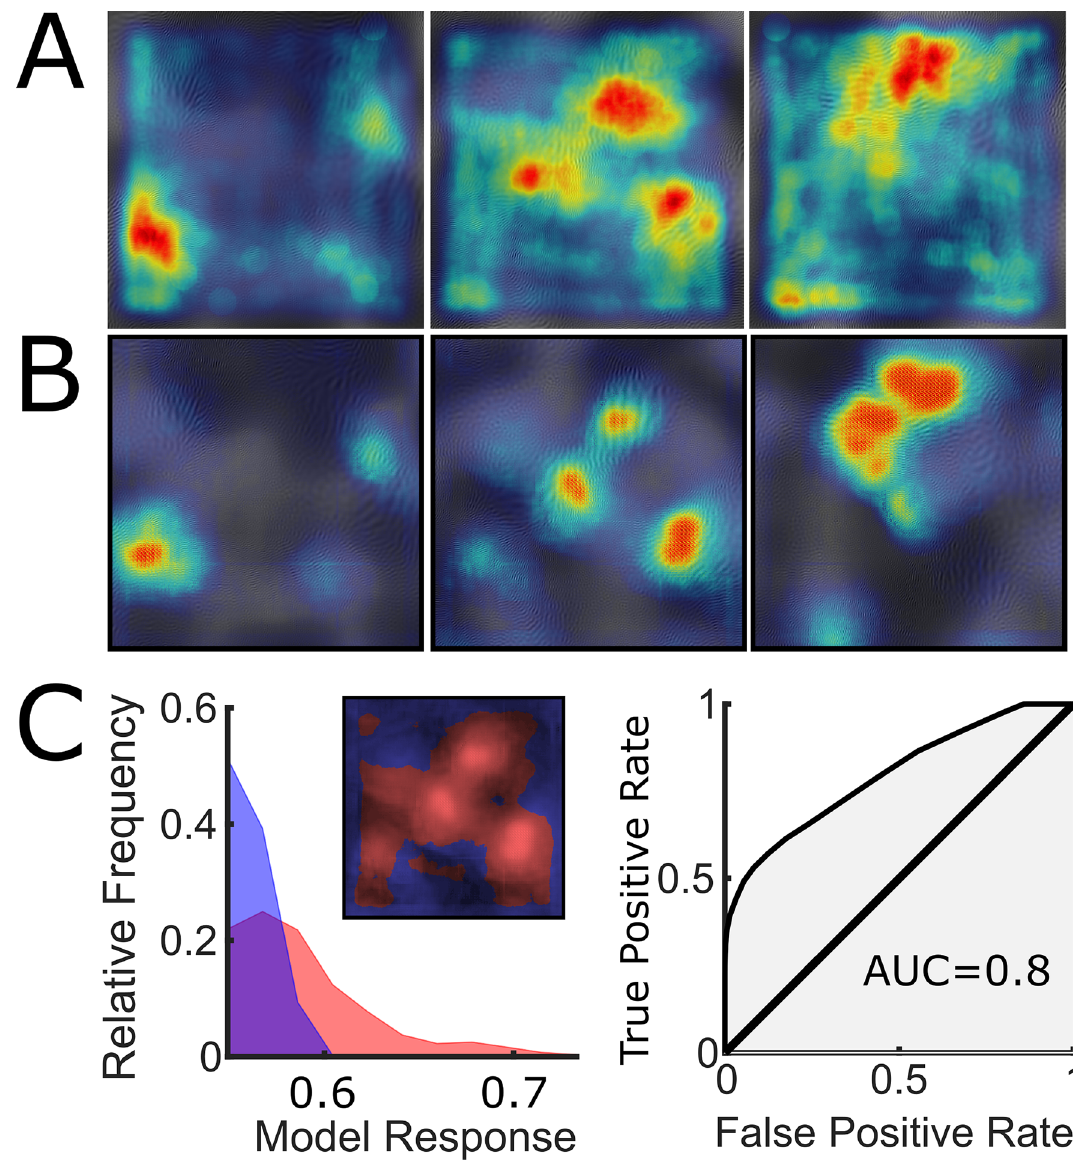
Figure 3. Model’s predictions. ( A ) Touch duration averaged across trials and participants for three example stimuli. ( B ) Model Predictions for the three stimuli. Each prediction corresponds to the stimulus above. Red represents high and blue low touch duration. The heat maps are depicted on top of the surface relief maps. To express model’s prediction the eight-bit output is normalized so that the maximum value corresponds to one. The minimum output value did not correspond to zero as predictions ranged between ~ 0.56 and 1. ( C ) Example of ROC analysis for the middle example stimulus in A&B. Left panel: the icon on the top right represents how the stimulus surface is split depending on touch duration. Red areas represent the half of the surface with higher touch duration. Blue areas the half with lower touch duration. Model’s predictions are represented by intensity: lighter areas correspond to predicted high touch duration and darker area to predicted low touch duration. The red distribution in the histogram represents the relative frequency ( y -axis) of the model’s prediction corresponding to the high touch duration half of the stimulus (red area in the icon). The blue corresponds to the low touch duration. Right panel: ROC curve corresponding to the low touch duration and the high touch duration distributions represented by the histograms in the left